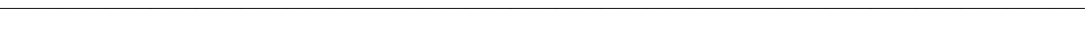
Fig. 2. Chondrichthyan remains from the Givetian of the Leningrad Region. A (cid:150) K , teeth of Karksiodus mirus Ivanov & M(cid:228)rss, 2011. A , B , PM SPU 70-1, Siverskij locality; Aruk(cid:252)la Regional Stage; A, lingual and B, labial views. C , D , PM SPU 70-2, Lemovzha locality; Aruk(cid:252)la Regional Stage; C, lateral and D, oblique lingual views. E , PM SPU 70-3, Kemka locality; Burtnieki Regional Stage; oblique basal view. F , PM SPU 70-4, Novinka locality; Burtnieki Regional Stage; occlusal view. G (cid:150) I , PM SPU 70-5, Zaitsevo locality; Aruk(cid:252)la Regional Stage; G, oblique basal and H, occlusal views, I, detail of a broken lateral cusp showing the vascular canals in the bottom of pulp cavity. J , K , PM SPU 70-6, Siverskaya locality; Aruk(cid:252)la Regional Stage; J, occlusal and K, oblique lingual views. L , Karksilepis parva M(cid:228)rss, 2008; PM SPU 70-7; scale in oblique crown view; Lemovzha locality; Aruk(cid:252)la Regional Stage. Scale bars for all figures equal 200 (cid:181)m except I, which is 100 (cid:181)m. Abbreviations: ant., anterior; cc, central cusp; dt, dentine tubules; ic, intermediate cusp; lvc, large vascular canal